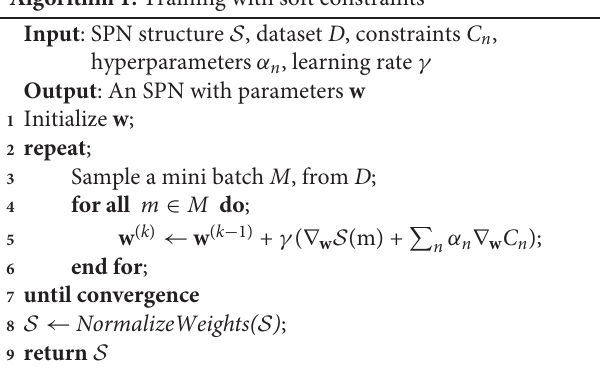
Algorithm 1: Training with soft